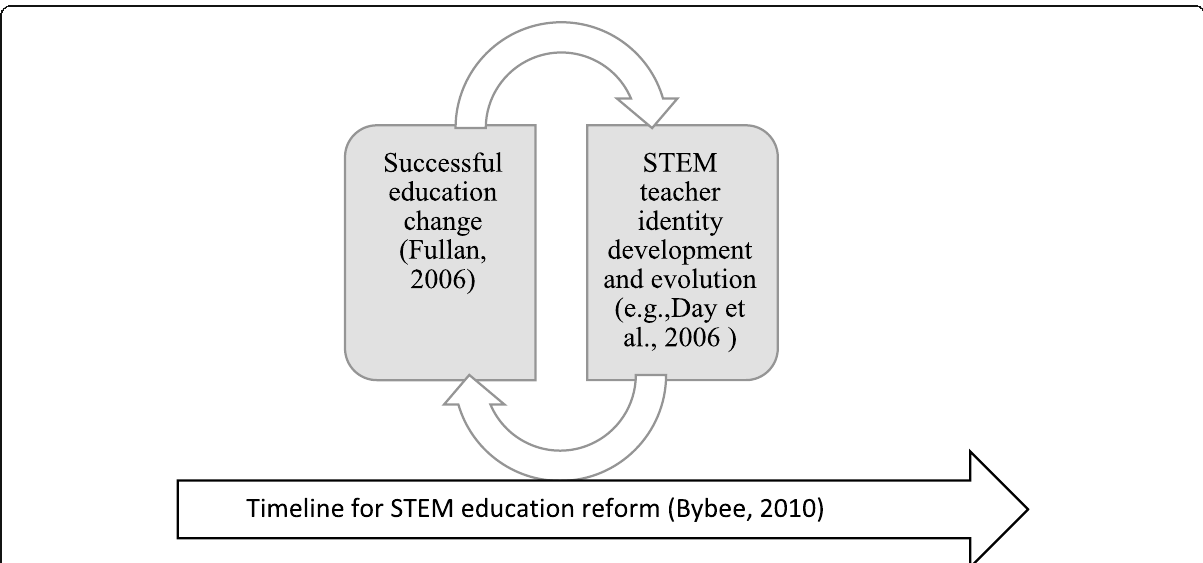
Fig. 1 Conceptualizing the relationship between chronological/sustained view of STEM reform with Fullan ’ s perspective of education change and teacher identity